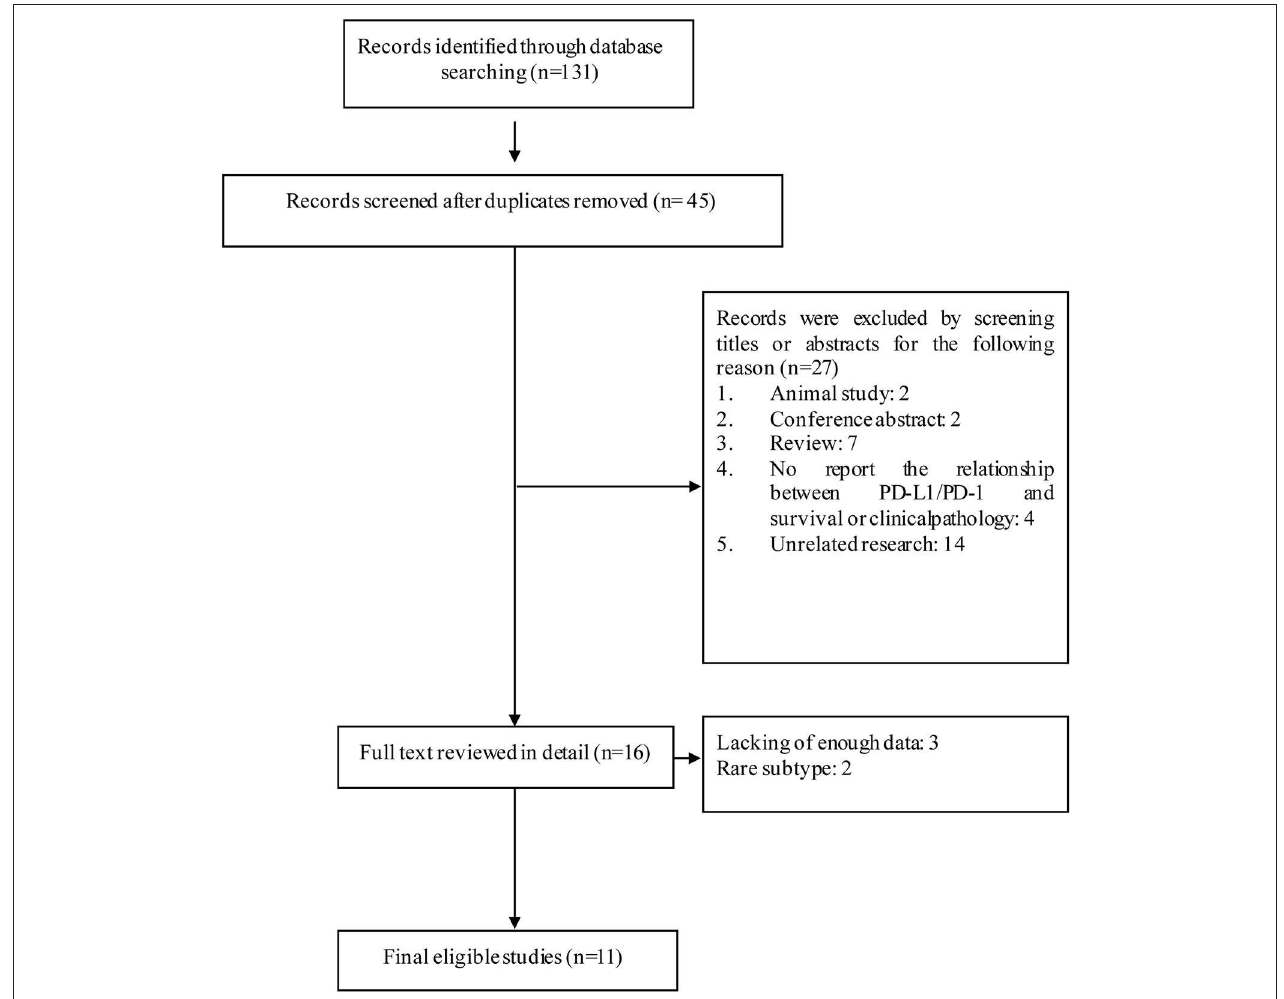
FIGURE 1 | Flow diagram of the study selection